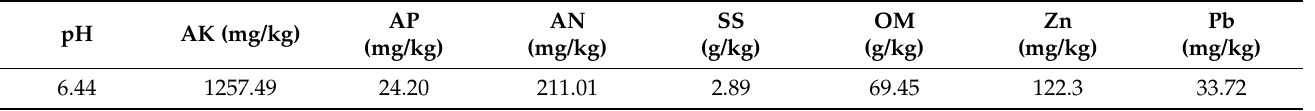
Table 1. Basic physical and chemical properties of black